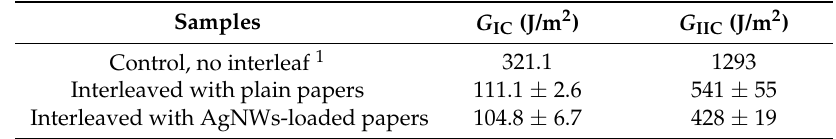
Table 2. Mode I and II fracture toughness of non-interleaved and interleaved